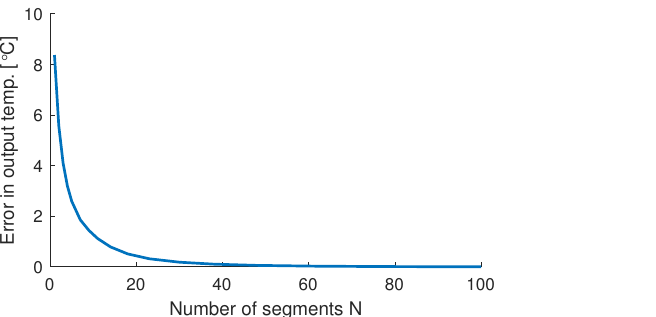
Figure 4. Maximal instantaneous error in output temperature for different numbers of N . Results from simulation with N = 100 is used as reference.